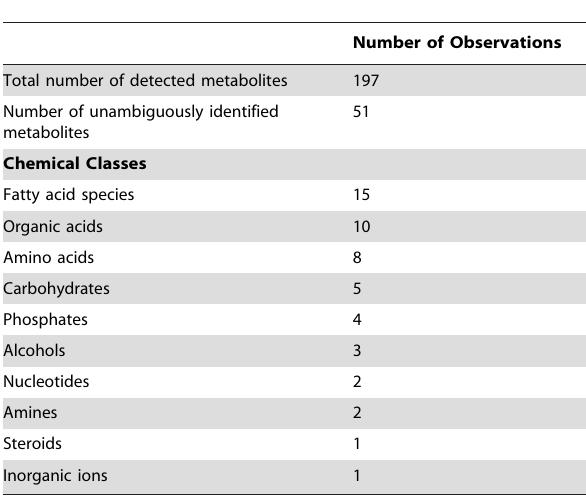
Table 1. Global characteristics of metabolomics dataset.